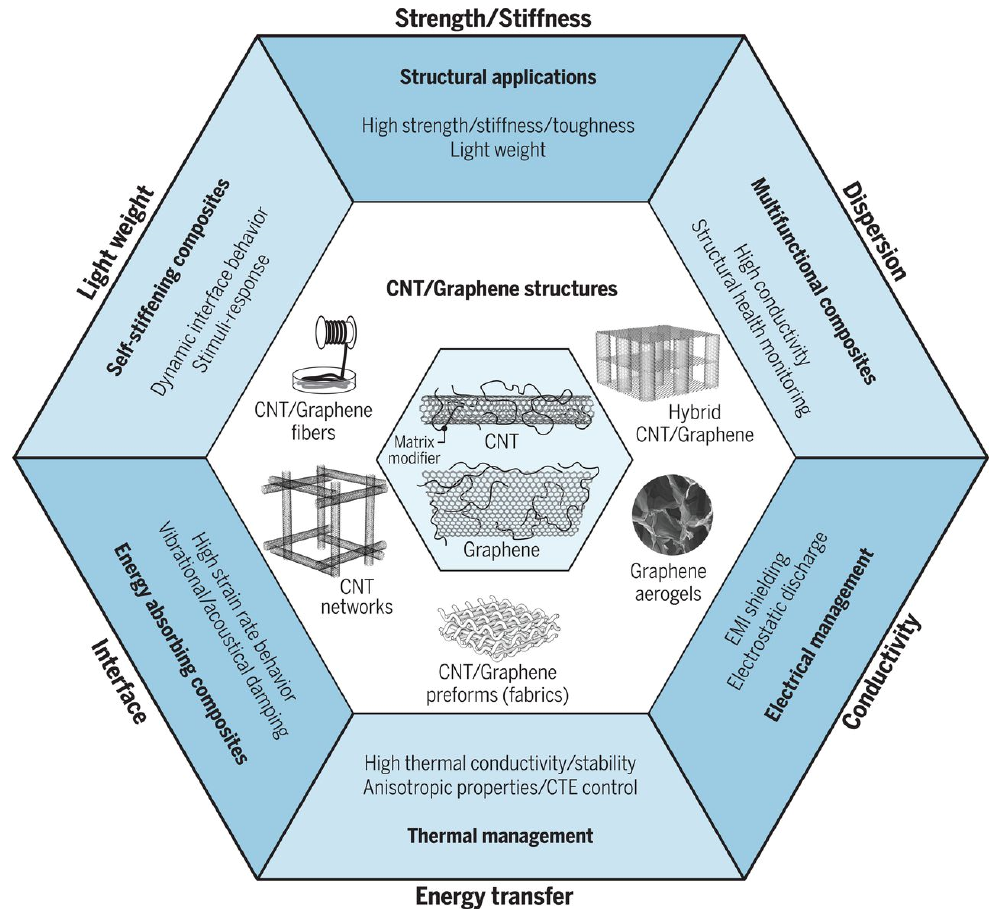
Figure 5. Rod-like CNT/graphene doped composites with anticipated enhanced properties [12].